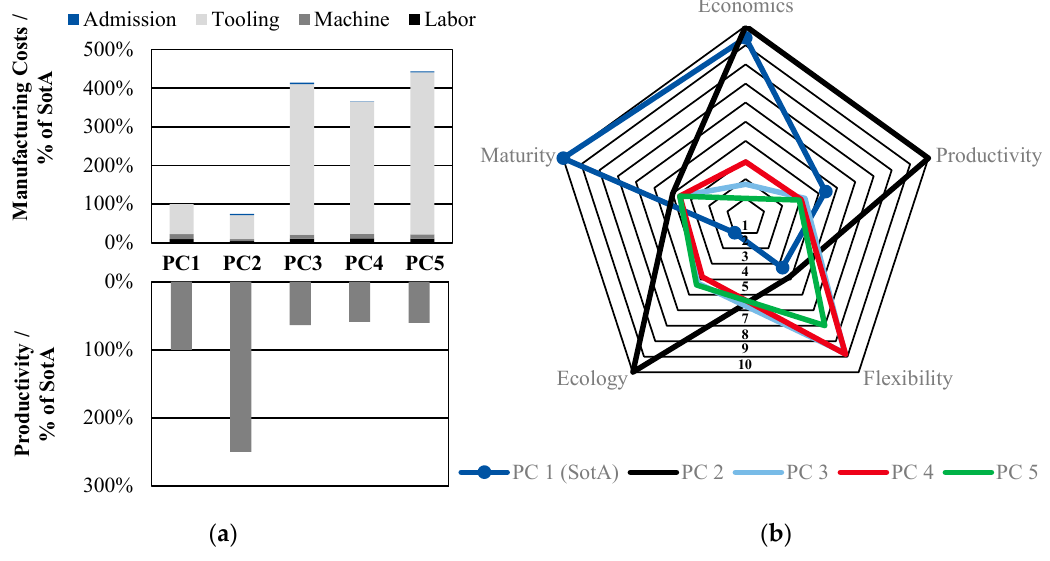
Figure 2. Results of the case study for the criteria productivity ( a ) and the multi-criteria assessment ( b ).